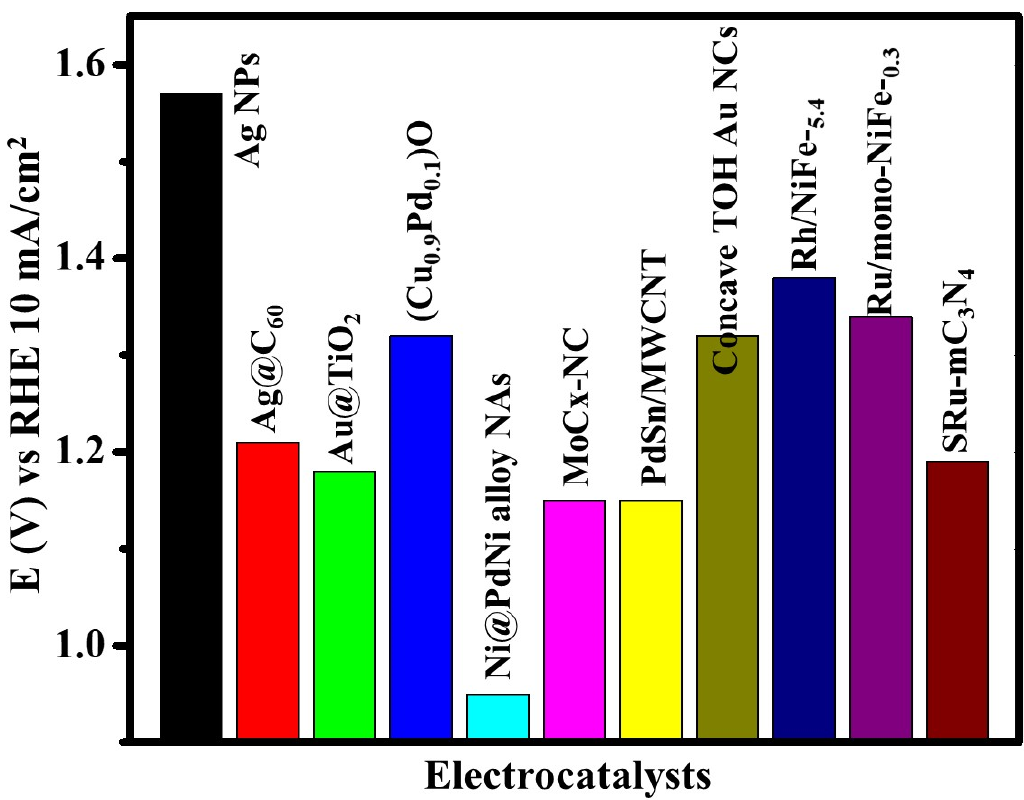
Figure 5. Electrochemical performance of hydrazine oxidation in previously reported systems from the literature on hydrazine oxidation reactions.